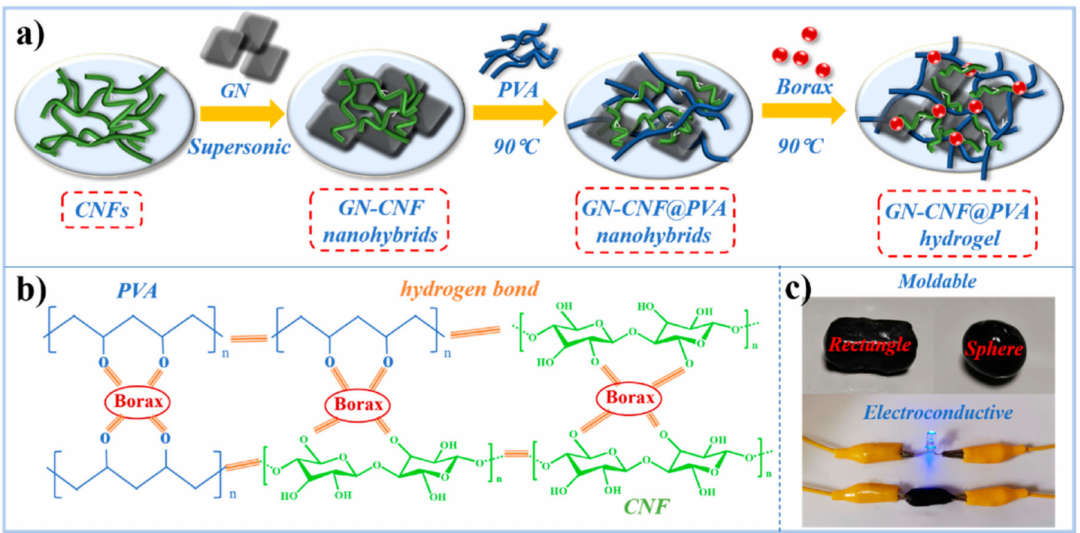
Figure 12. ( a ) Schematic representation of the preparation of graphene-cellulose nanofibers with poly(vinyl alcohol) (GN-CNF@PVA) hydrogels; ( b ) representation of the mechanism of the formation of the hydrogel network with borax; ( c ) illustration of malleability and electroconductivity of the hydrogels. Reprinted with permission from reference [81]. Copyright 2019